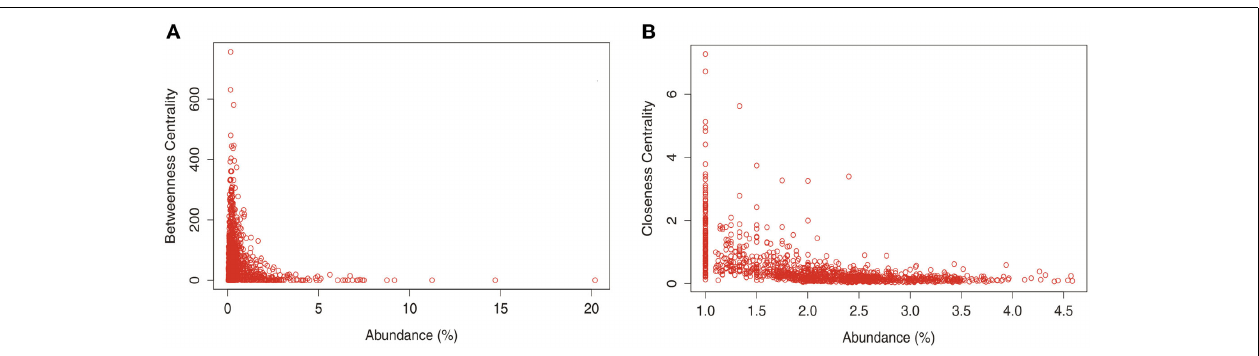
FIGURE 6 | Relationship between taxon relative abundance data from the total number of OTUs at genus level found in different land uses in Pampa and Cerrado biome and betwenees (A) and closeness (B)